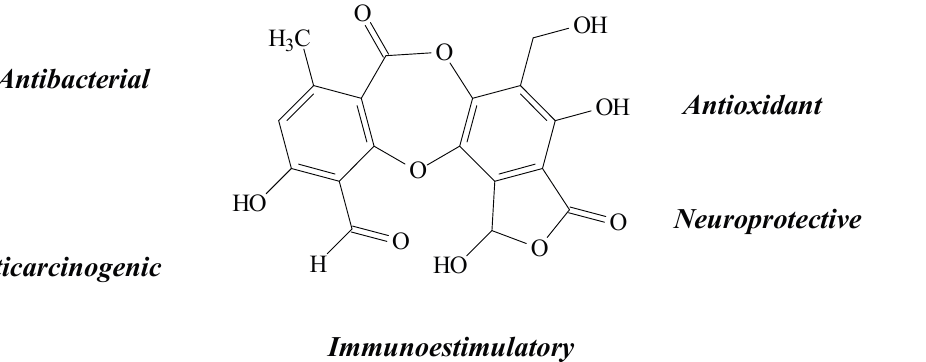
Figure 9. Salazinic acid structure and biological